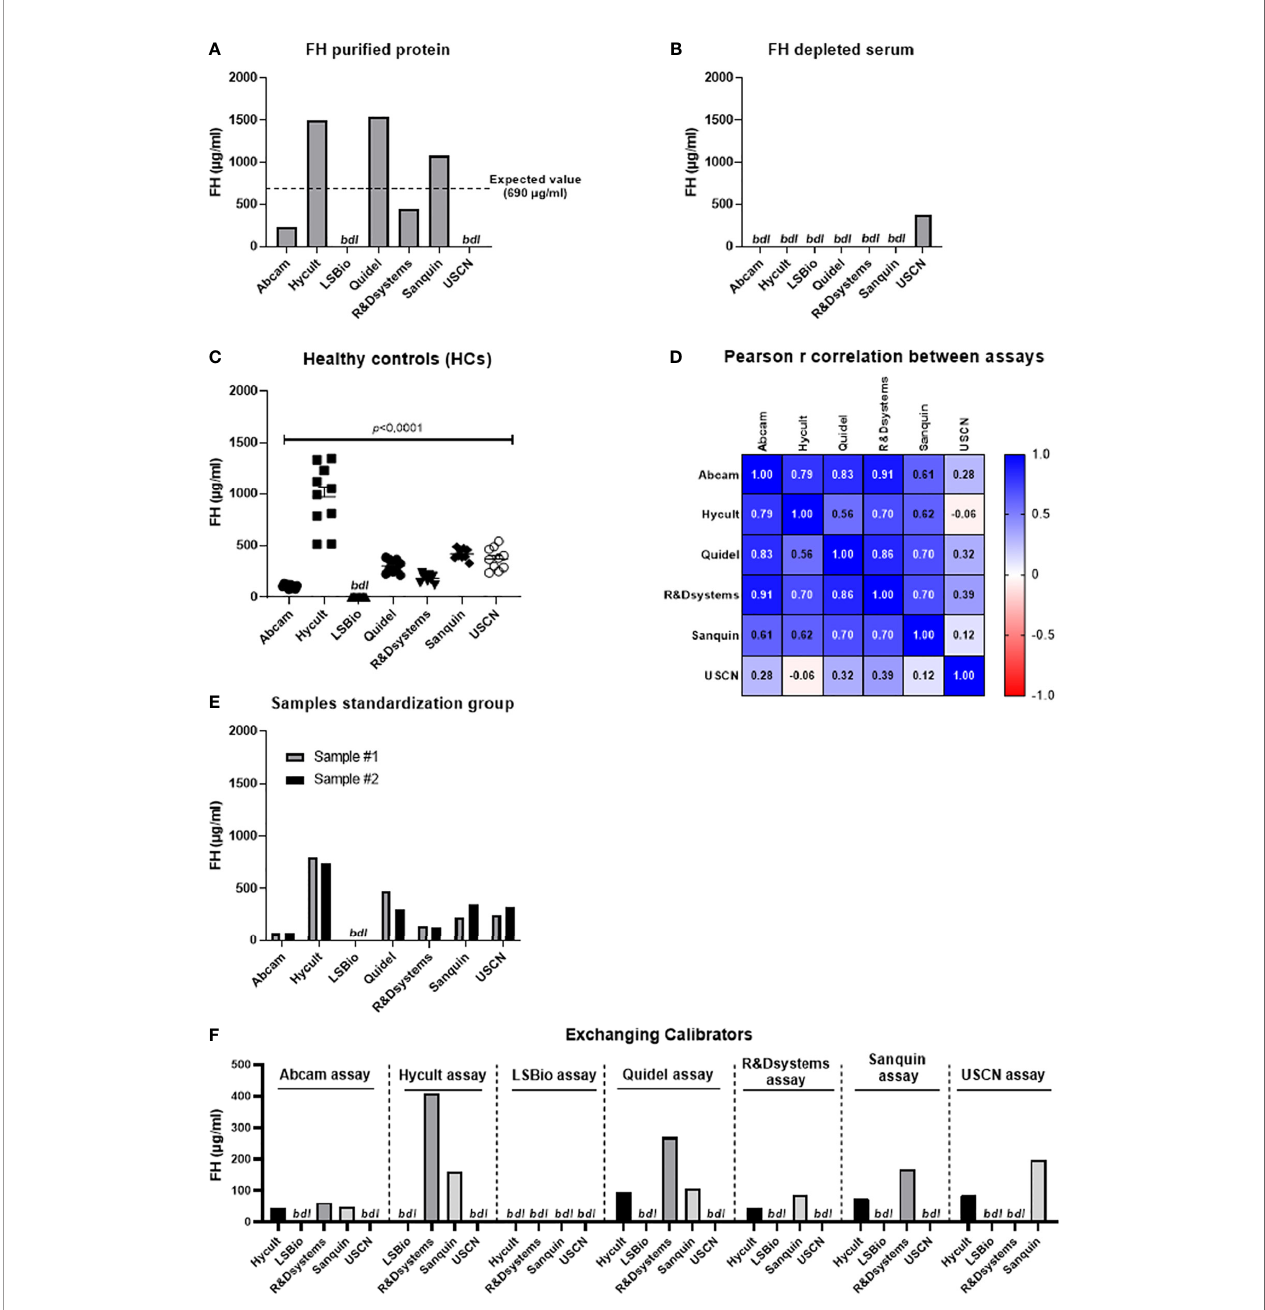
FIGURE 2 | Assessment of Factor H levels in samples using seven different assays. (A) Assessment of Factor H (FH) puri fi ed protein in PBS (expected value is 690 µg/ml). (B) Assessment of FH levels in FH depleted serum. (C) Assessment of systemic FH levels in samples derived from healthy controls (n=10). Data are represented as mean ± SEM. Data were analyzed using the one-way ANOVA (Graphpad Prism 8.4.2, San Diego, CA, USA). A p-value <0.05 was considered signi fi cant. (D) Pearson r correlation coef fi cient. Pearson coef fi cients range from +1 to -1, with +1 representing a positive correlation of FH sample values between assays, -1 representing a negative correlation of FH sample values between assays, and 0 representing no relationship. No correlation could be calculated for the LSBio assay as no FH levels were obtained using this assay. (E) Assessment of FH levels in 2 serum pool samples obtained from the Complement EQA Group. (F) Assessment of calibrators as sample in each assay. All calibrators were exchanged between the seven assays except for the Abcam and Quidel calibrator as not enough calibrator was provided with these kits to be included in each assay as sample. FH, factor H; HCs, healthy controls; bdl, below detection